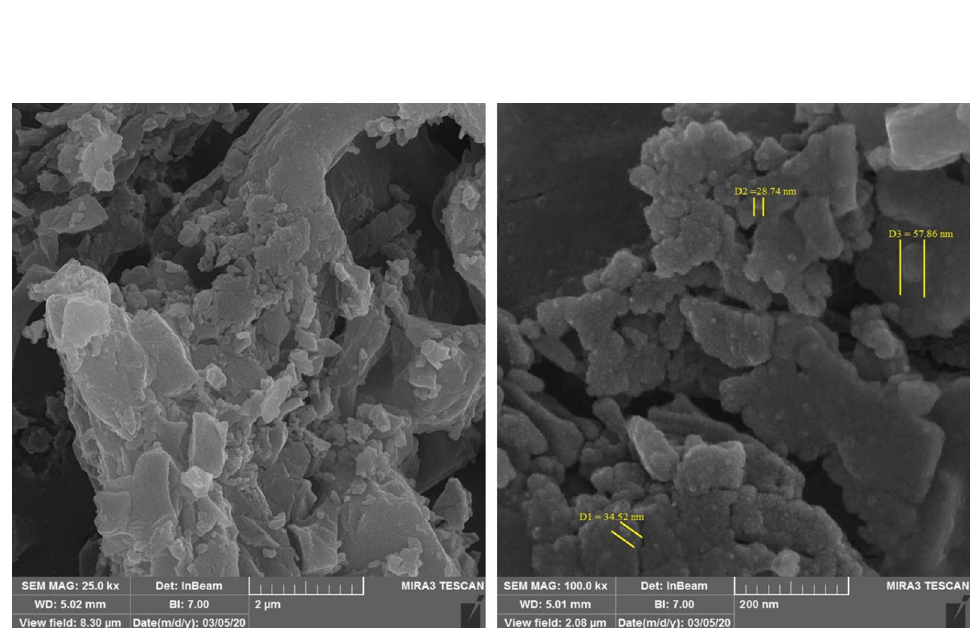
Figure 5. FESEM images of the Cs-EDTA-Cell network ( 1